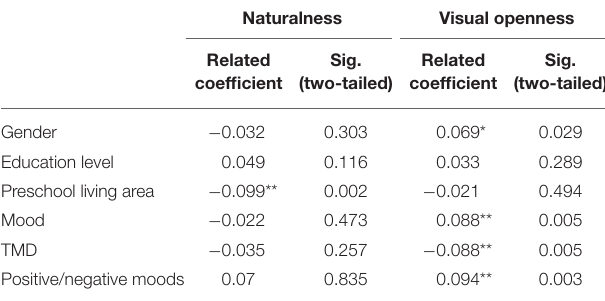
TABLE 2 | Correlation analysis.